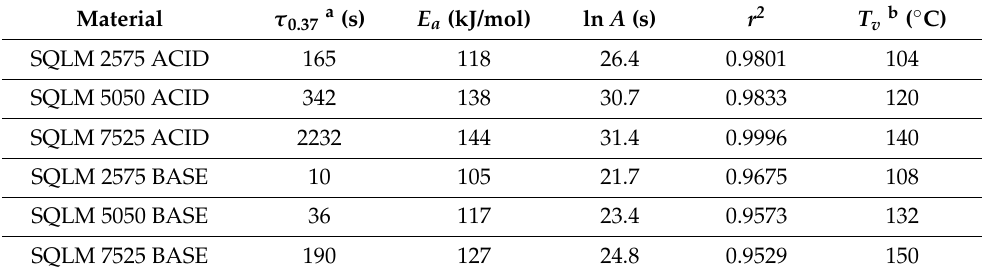
Table 4. Main data extracted from relaxation-stress experiments of the materials.